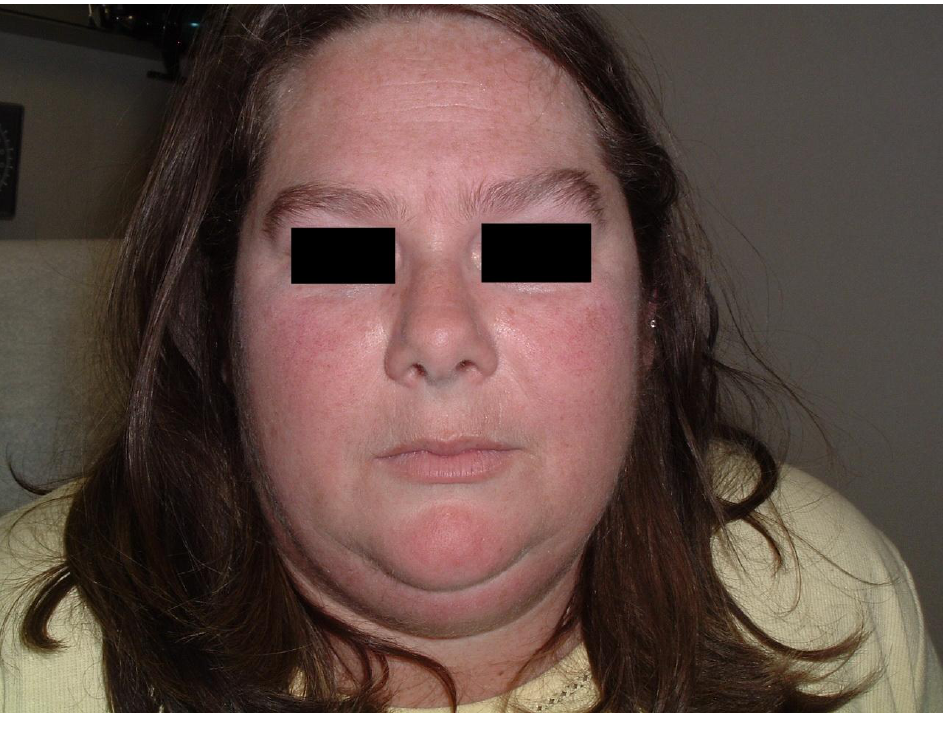
FIGURE. Rubeosis faciei diabeticorum in a patient with diabetes